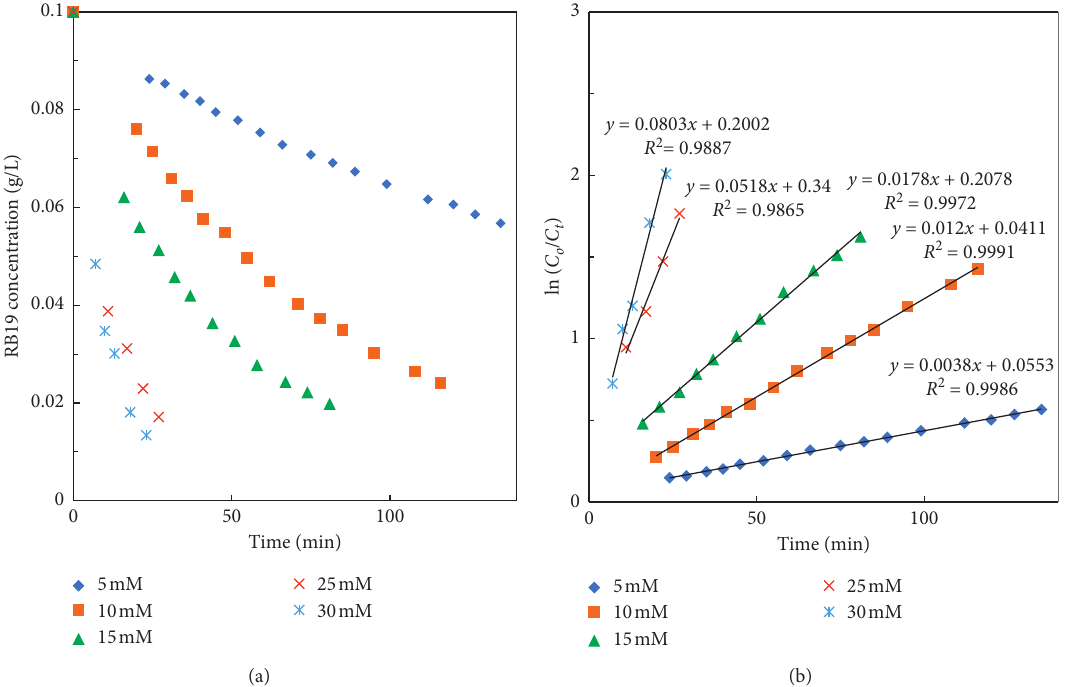
) vs . time at different HCO − t